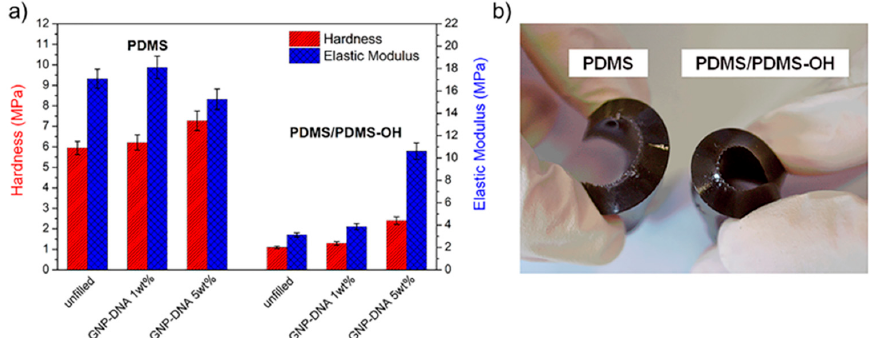
Figure 10. ( a ) Mechanical properties of nanocomposites with silicone-based matrices, the PDMS (Sylgard 184) and the PDMS/PDMS–OH blend (75:25 w/w), and GNP–DNA filler from nanoindentation tests (0.5 mN applied load, standard deviations in the range of 5–8%); ( b ) the flexibility of nanocomposites with 5 wt% of GNP–DNA.